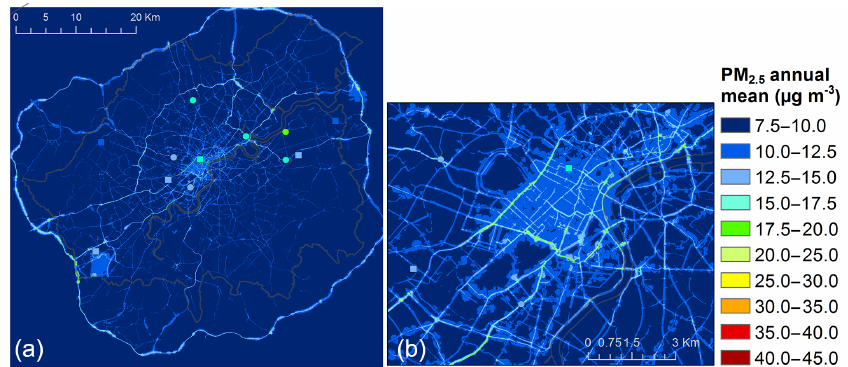
Figure 7. PM 2 . 5 annual average concentration contours from the coupled model for the whole of Greater London (a) and an area of central London (b) , with monitoring data overlaid – round symbols for near-road sites and square symbols for background